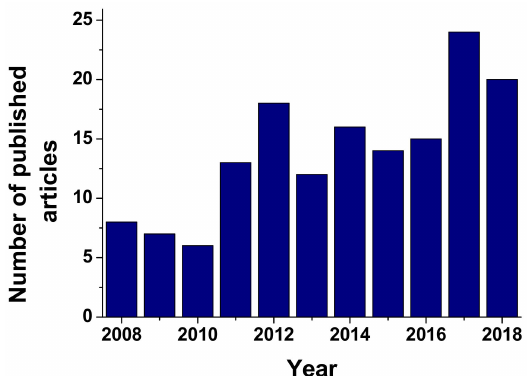
Figure 2. Number of articles containing Peptide biosensor in their title published in Scopus